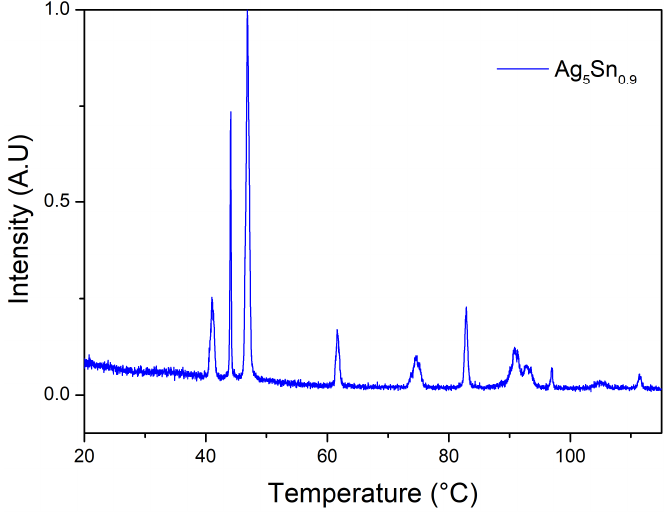
Figure 4. X-ray diffractogram of Ag 5 Sn 0.9 particles.